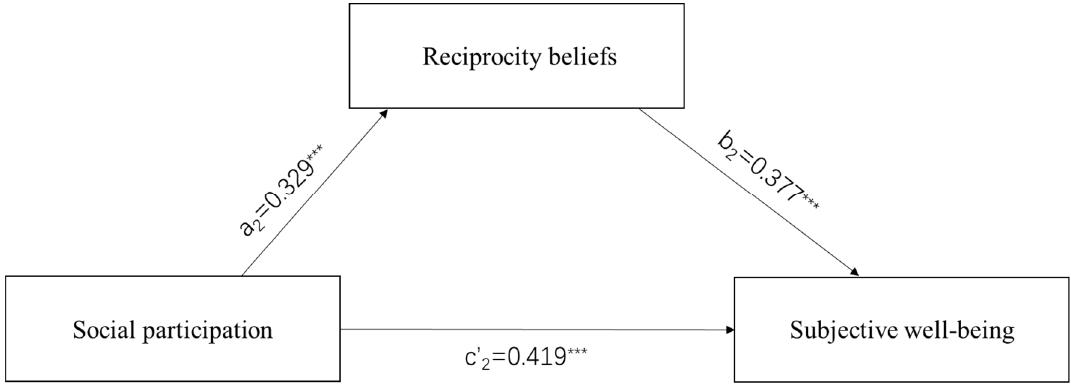
Figure 2. Mediation model of older women in Chengdu. *** p < 0.001.